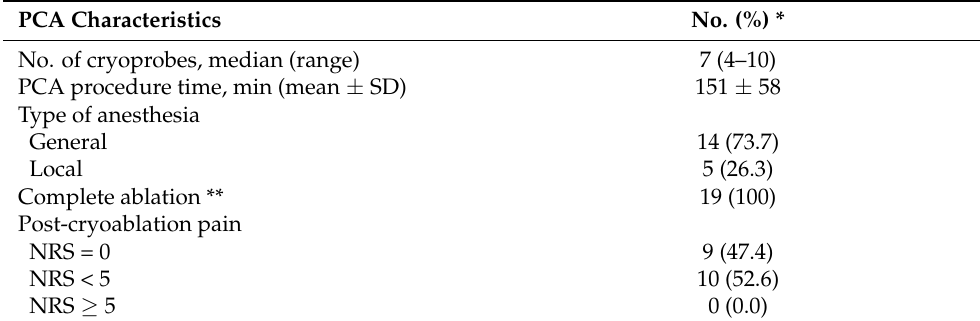
Table 4. Characteristics of the percutaneous cryoablation (PCA) procedure of the 20 malignant kidney tumors performed after selective arterial embolization in the 19 patients.